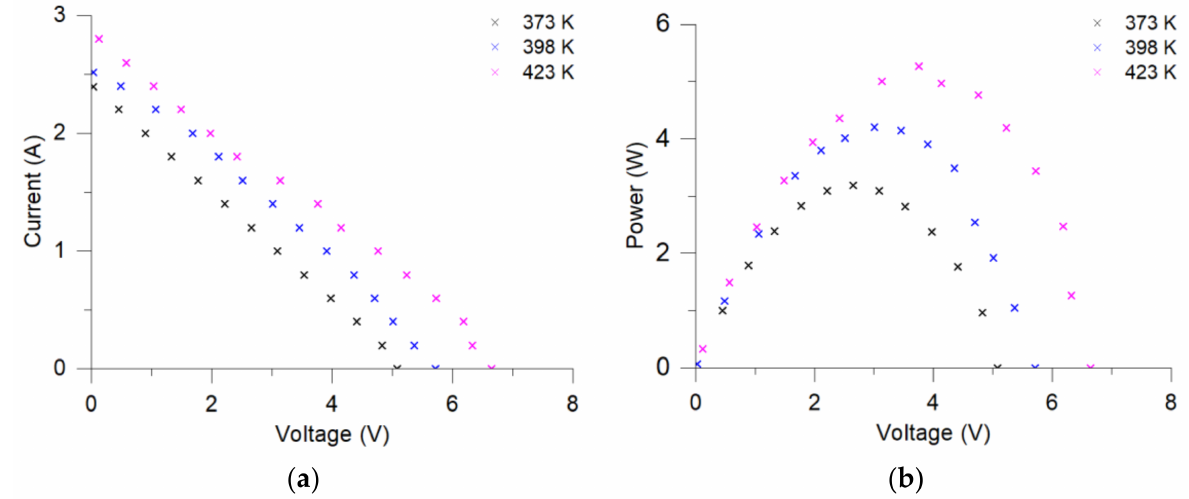
Figure 12. I–V ( a ) and P–V ( b ) characteristics of the tested TEG No.